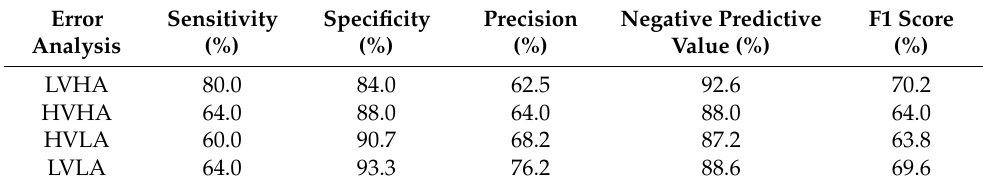
Table 9. The error analysis of results on frontal electrodes with polynomial order fixed at 3.